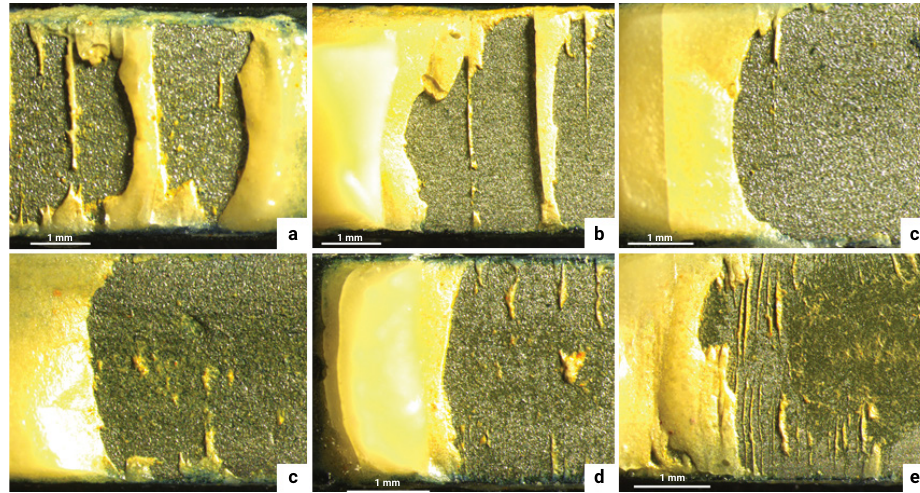
Figure 1. Aspect of the metal surface without welding: APA a) 250 μm, b) 100 μm and c) 50 μm. Aspect of the metal surface with TIG welding: APA c) 250 μm, d) 100 μm and e) 50 μm.